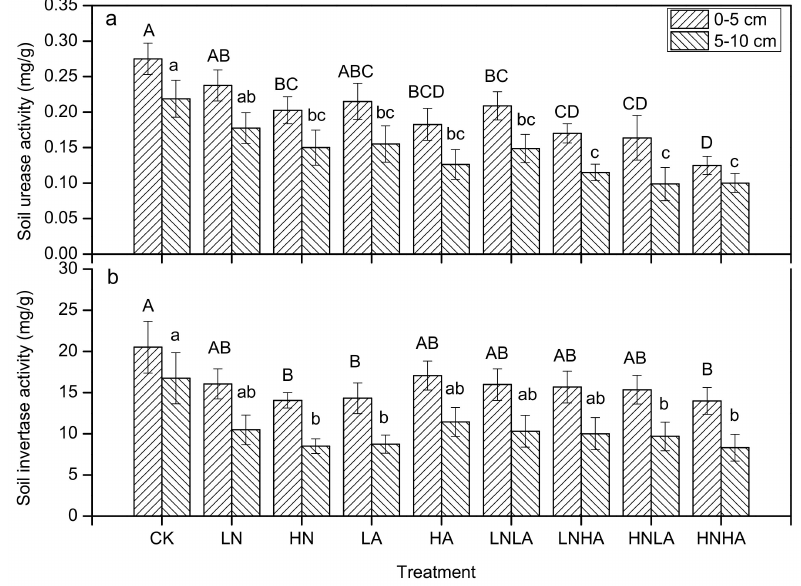
Figure 4. E ff ects of N and acid addition on the activity of soil urease ( a ) and invertase ( b ). Error bars indicate a standard error ( n = 8). Di ff erent lowercase letters indicate significant di ff erences at a p < 0.05 level under di ff erent